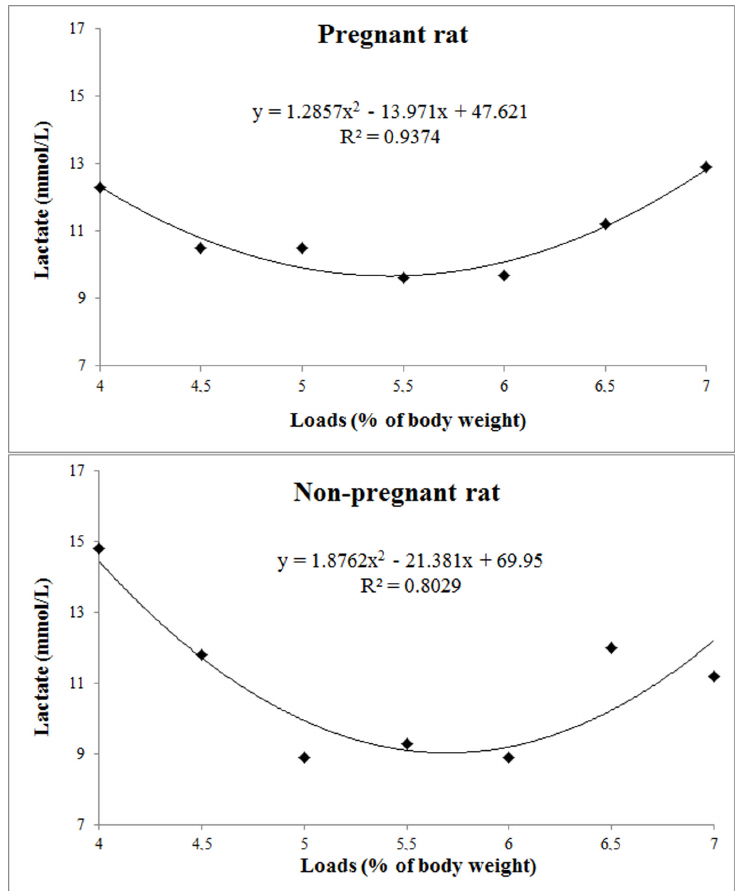
Figure 2 - Blood lactate concentration (mmol/L) and load (% of body weight) of pregnant and non-pregnant rats during lactate minimum (LacMin)